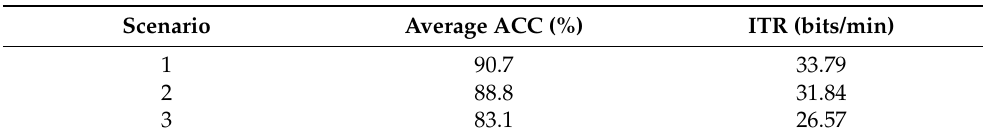
Table 14. The average accuracy for the direction test (Scenario 1), the room information test (Scenario 2) and the map test (Scenario 3) using a screen with CCA classifier.